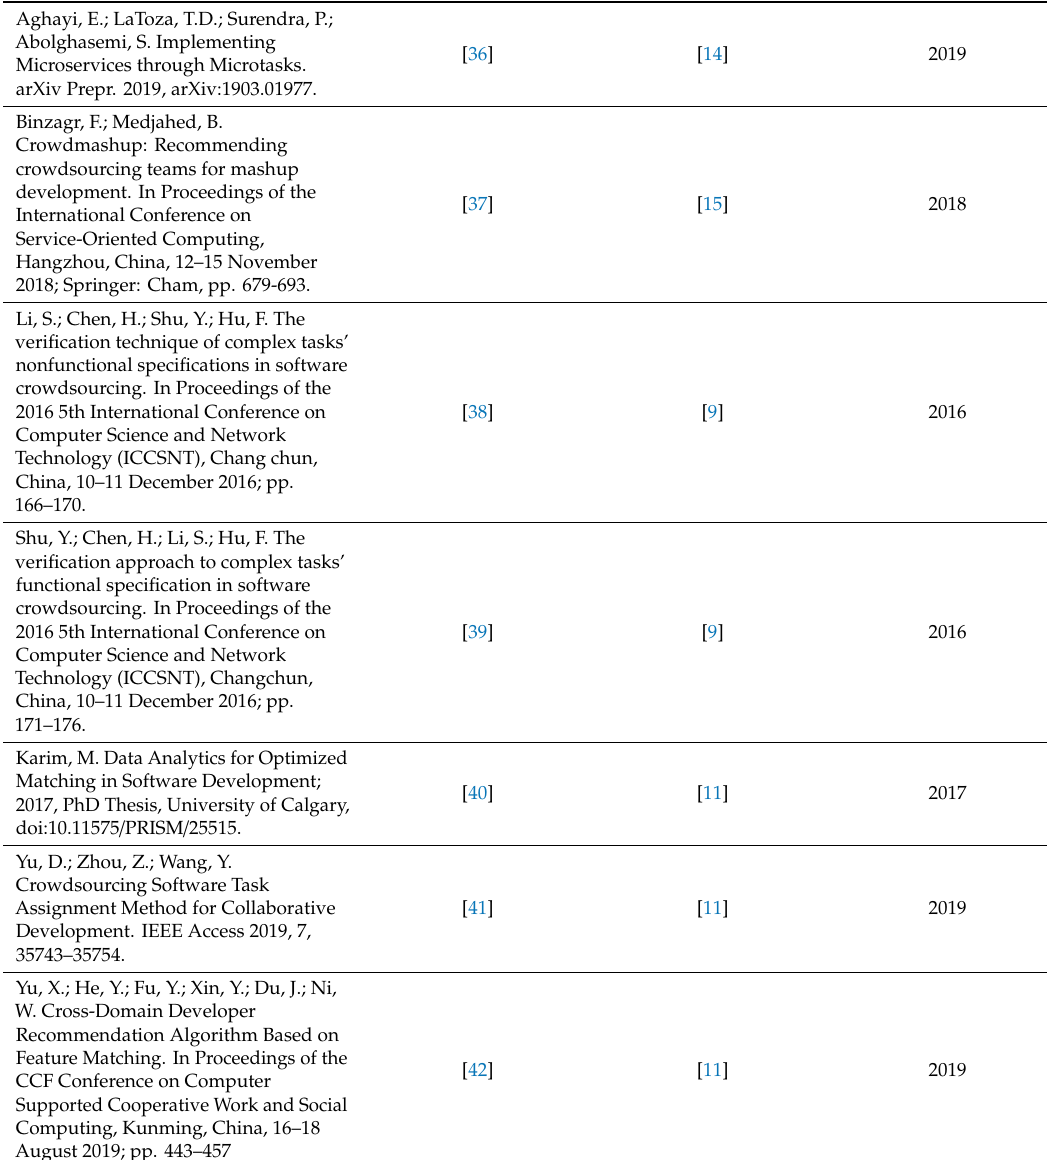
Table 4 highlights the relation between the parent reference ID and the child reference ID (Google citation included for meeting the research objectives of this systematic mapping